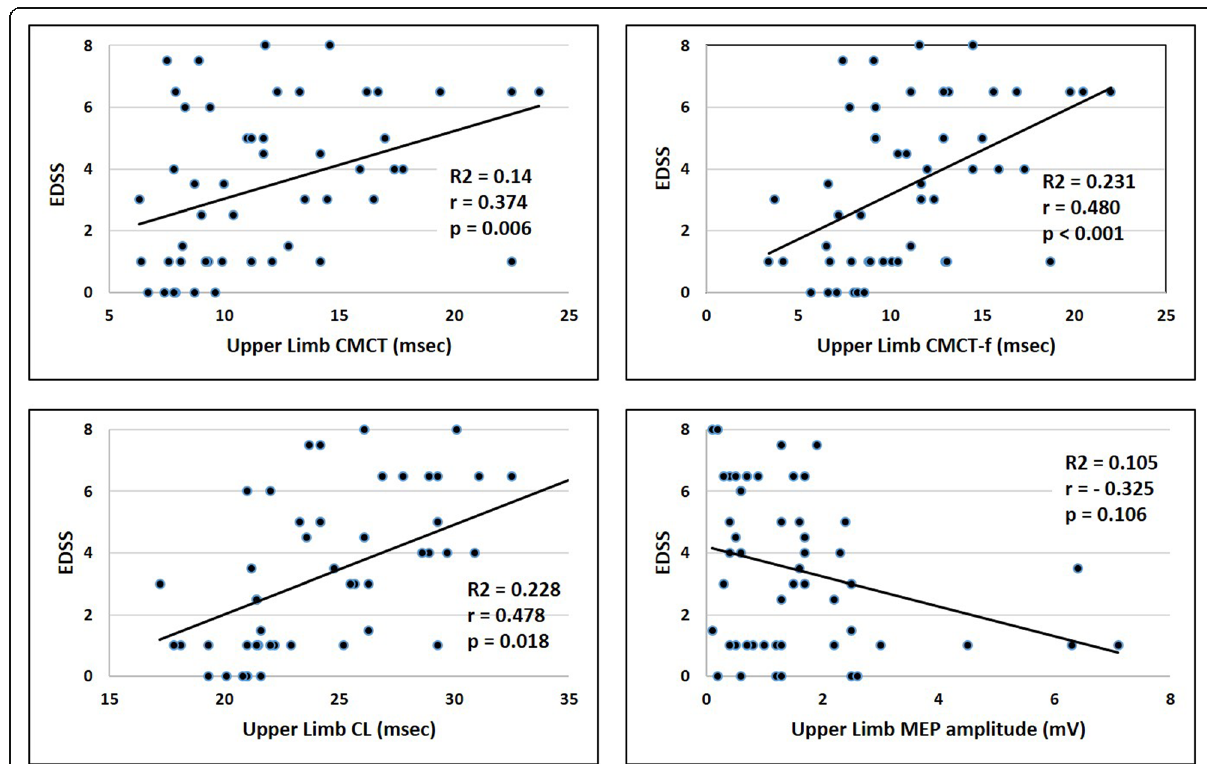
Fig. 1 Relationship of EDSS and upper limb CMCT (upper left), CMCT-f (upper right), CL (lower left), and MEP amplitude (lower